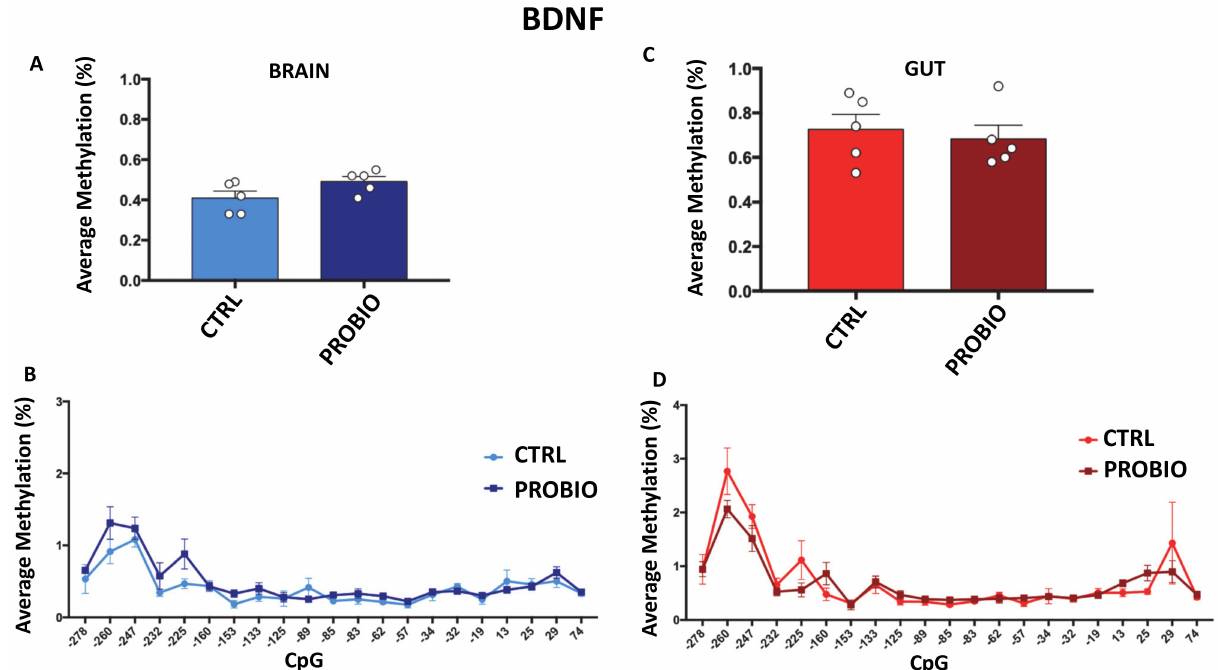
Figure 3. DNA methylation of BDNF in probiotic-treated and untreated Zebrafishes in the gut and brain. ( A ) Average methylation (%) of BDNF in the brain of untreated (CTRL) and probiotic-treated (PROBIO) Zebrafishes . Statistical analysis was performed using Student t -test. ( B ) Methylation level (%) at single-CpG sites was shown for the brain of CTRL and PROBIO groups. ( C ) BDNF average methylation (%) in the gut of untreated (CTRL) and probiotic-treated (PROBIO) Zebrafishes . Statistical analysis was performed using Student t -test. ( D ) Single-CpG methylation (%) at the BDNF promoter in the gut of CTRL and PROBIO groups. Statistical analyses were performed using one-way ANOVA followed by Tukey’s multiple comparison post-hoc